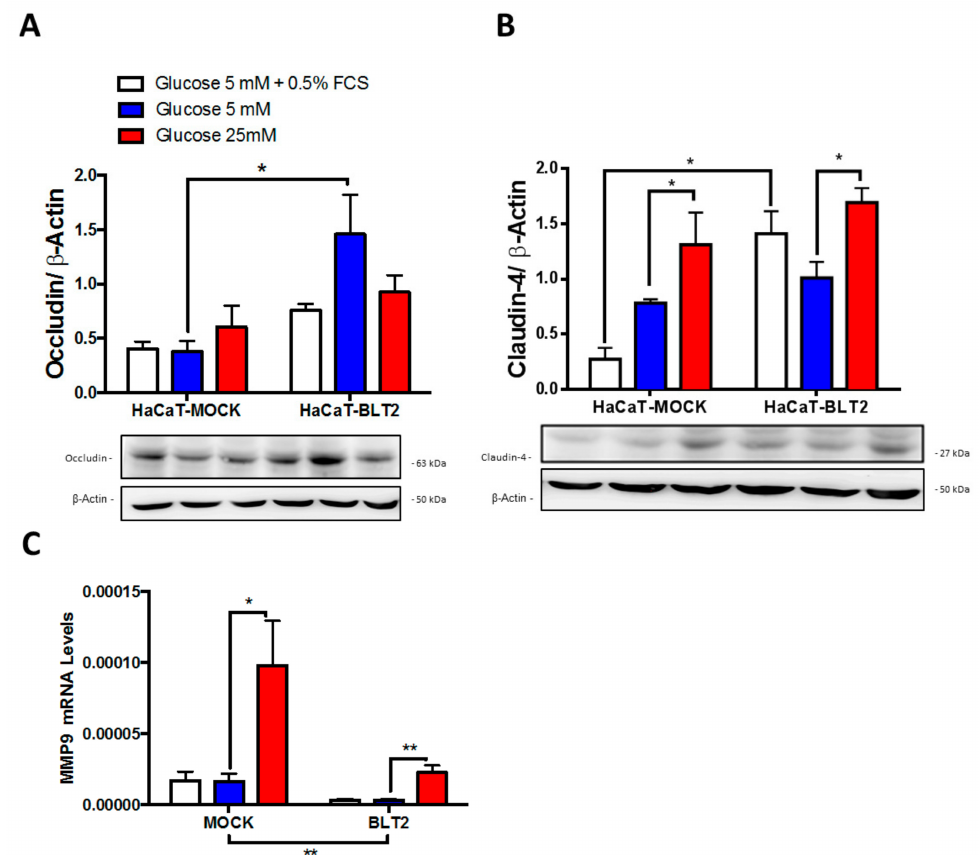
Figure 3. HaCaT-BLT2 cells present higher occludin levels and lower MMP9 expression: ( A ) Western blots for occludin; ( B ) Western blots for claudin-4; and ( C ) Q-PCR for MMP9 in di ff erent glucose levels for 48 h. Data represent the mean ± SEM of n = 3 independent experiments * p < 0.05, one-way non-parametric ANOVA (Kruskal–Wallis test).